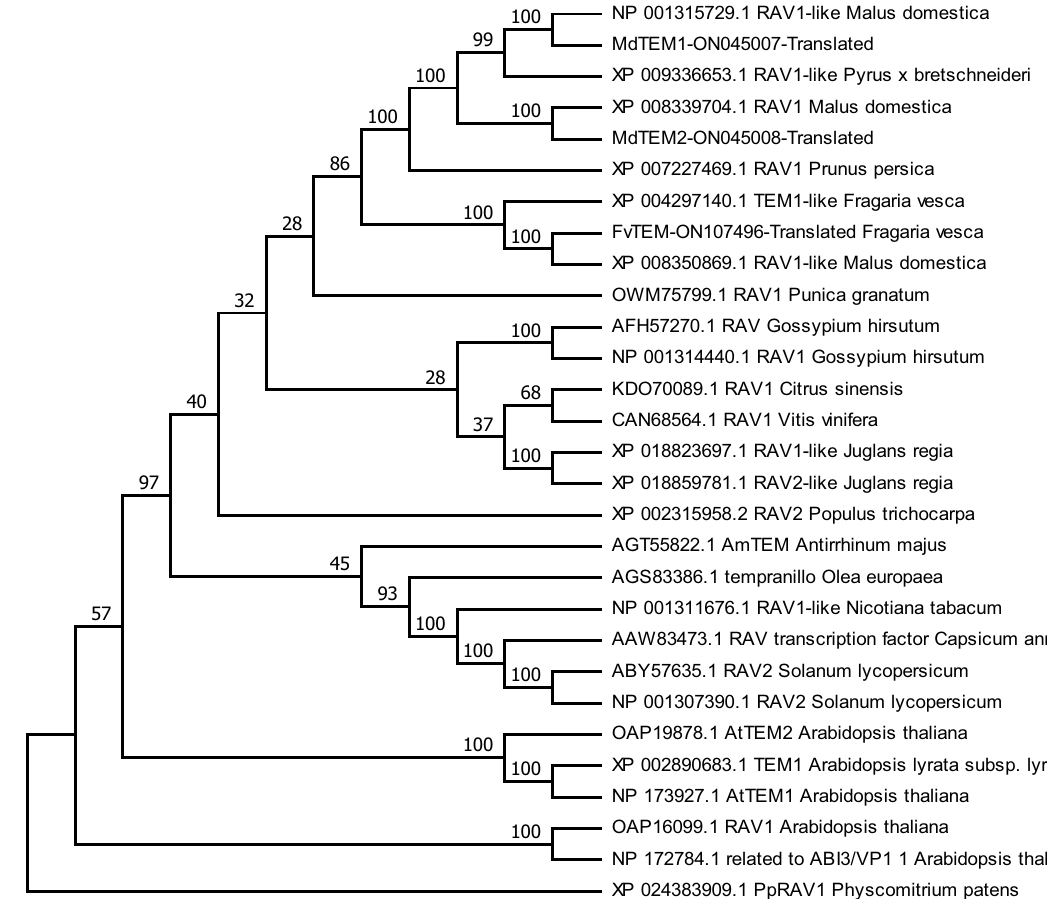
Figure 1. Phylogenetic analysis of FvTEM deduced amino acid sequences and other RAV sub-family class I members. The evolutionary history was inferred using the Neighbor-Joining method 1 . The optimal tree is shown. The percentage of replicate trees in which the associated taxa clustered together in the bootstrap test (500 replicates) are shown next to the branches 2 . The evolutionary distances were computed using the Poisson correction method 3 and are in the units of the number of amino acid substitutions per site. This analysis involved 28 amino acid sequences. All ambiguous positions were removed for each sequence pair (pairwise deletion option). There were a total of 490 positions in the final dataset. PpRAV1 used as an outgroup for rooting. Evolutionary analyses were conducted in MEGA11 4 . Accession numbers are given next to the species